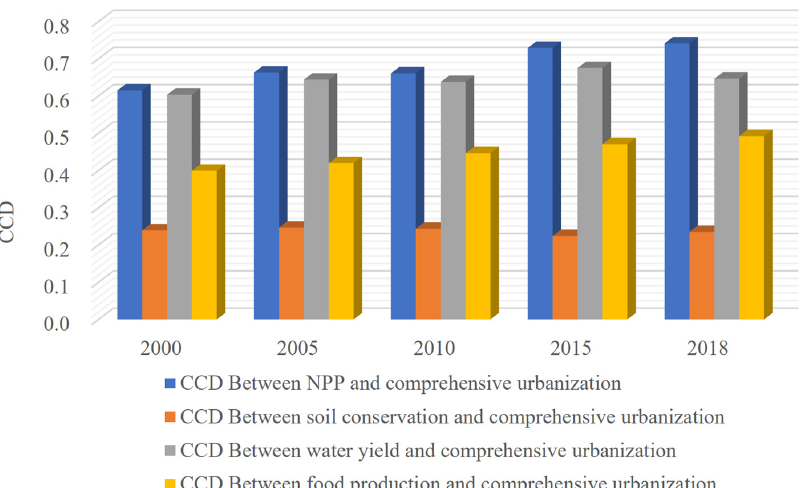
Figure 9. Temporal change in the coupling coordination between ESs and comprehensive urbaniza- tion in the AYRHP.